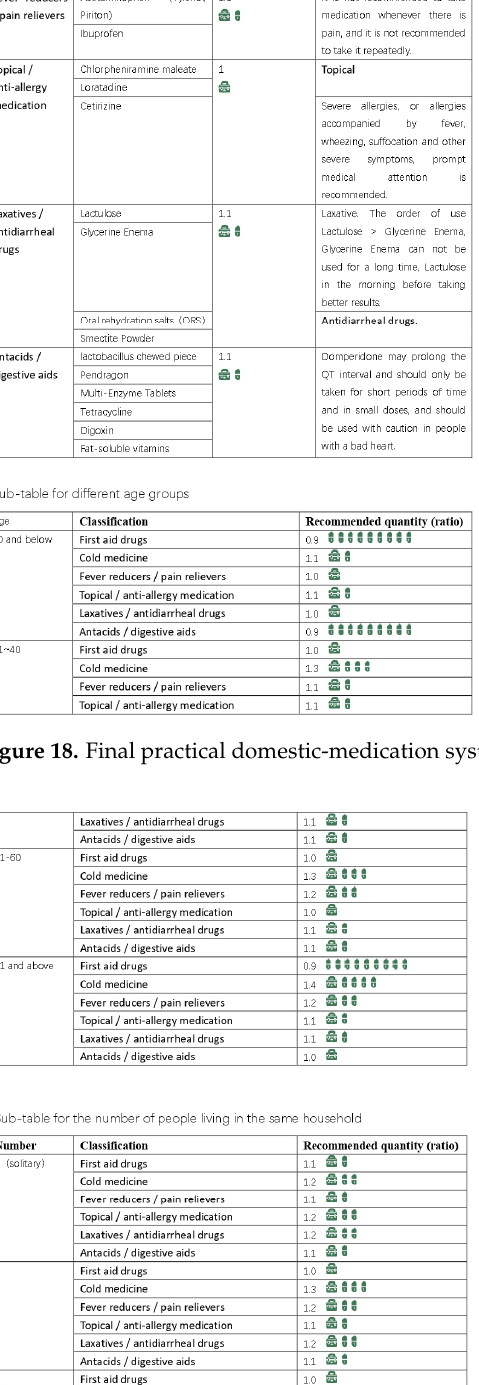
Figure 17. Final practical domestic-medication system.